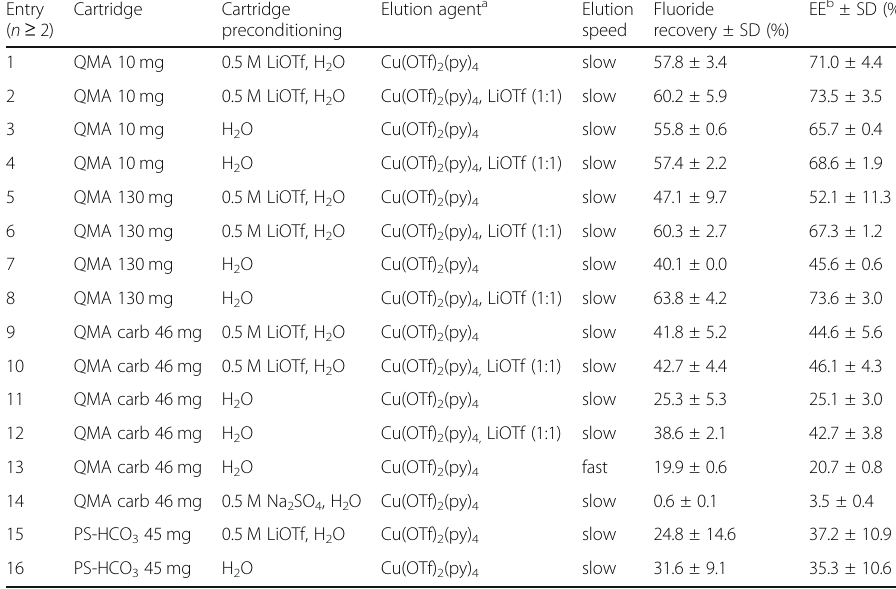
Table 1 Preliminary results of [ 18 F]fluoride elution studies with various preconditioning and elution